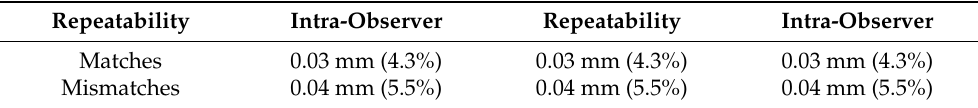
Table 1. Intra- and inter-observer error in matches and mismatches. TEM: technical error measure- ment; rTEM: relative technical error